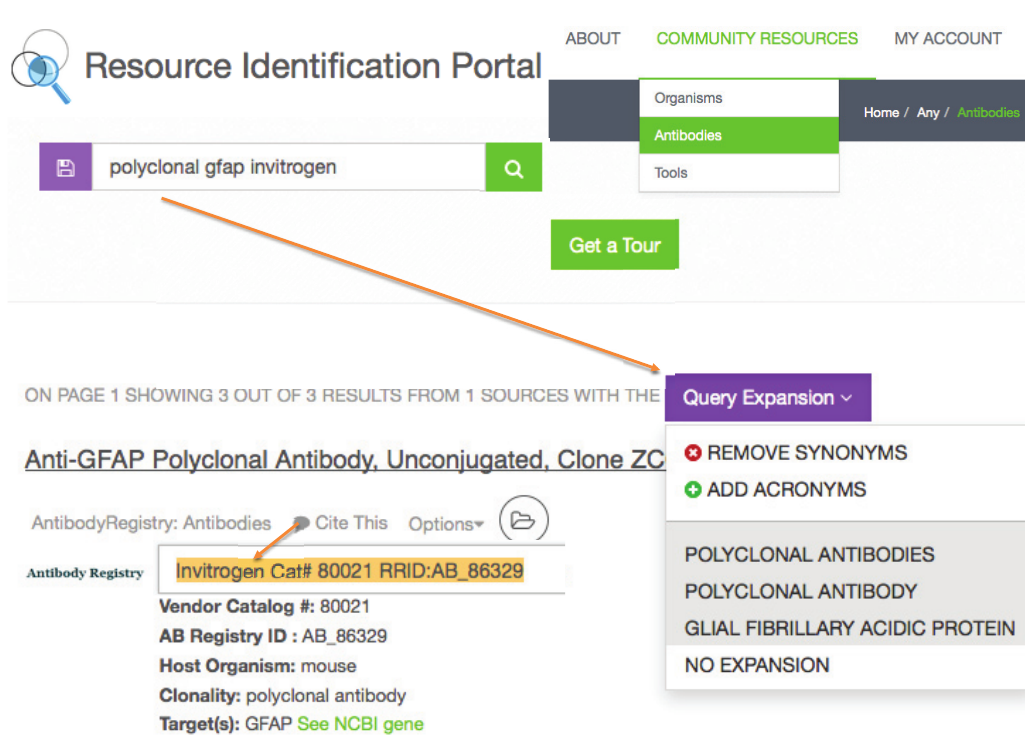
Figure 1. The Resource Identification Initiative portal containing citable Research Resource Identifiers (RRIDs). The workflow for authors is to visit http://scicrunch.org/resources, then select their resource type (see community resources box), type in search terms (note that the system attempts to expand known synonyms to improve search results) and open the “Cite This” dialog box. The dialog shown here displays the Invitrogen catalog number 80021 antibody with the RRID:AB_86329. The authors are asked to copy and paste this text into their methods